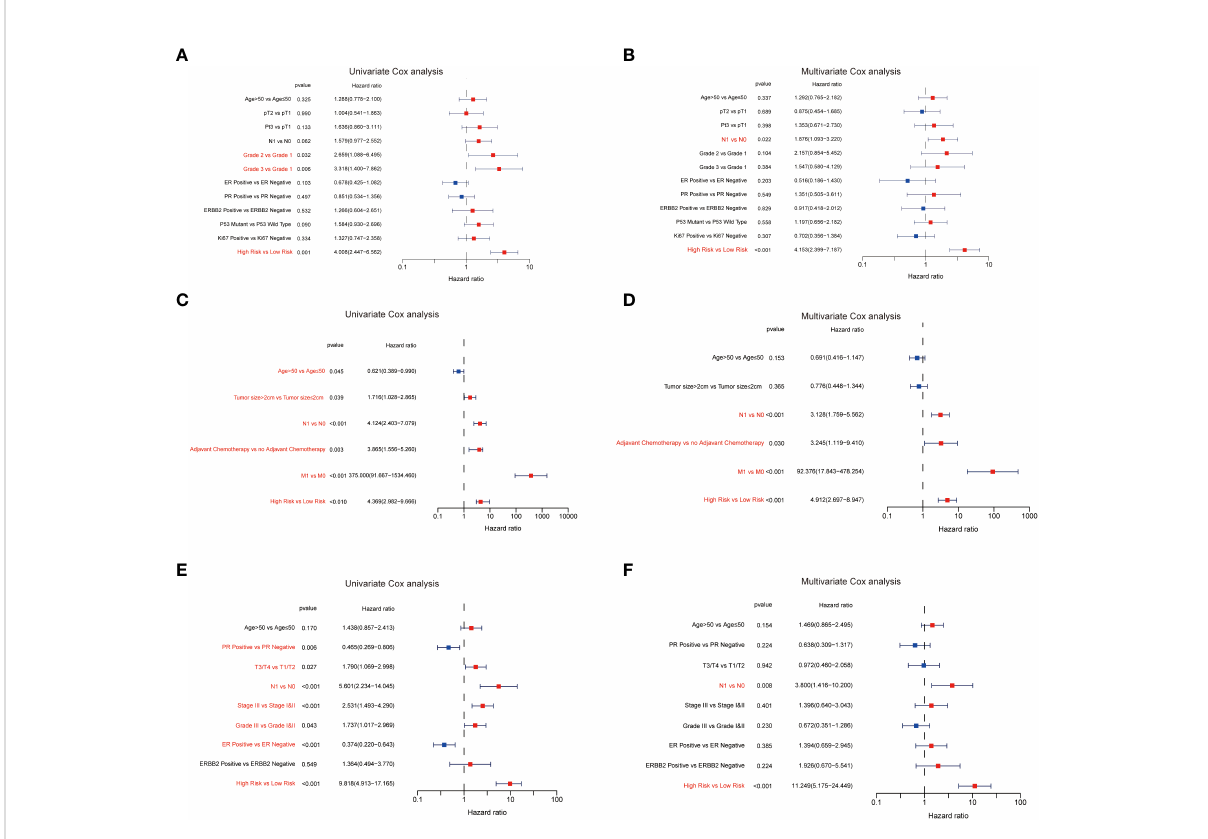
FIGURE 5 The predictive value of the senescence ‐ related signature. The results of the univariate Cox analysis in GSE21653 (A) , GSE20685 (C) , and GSE25055 (E) . The results of the multivariate Cox analysis in GSE21653 (B) , GSE20685 (D) , and GSE25055 (F)